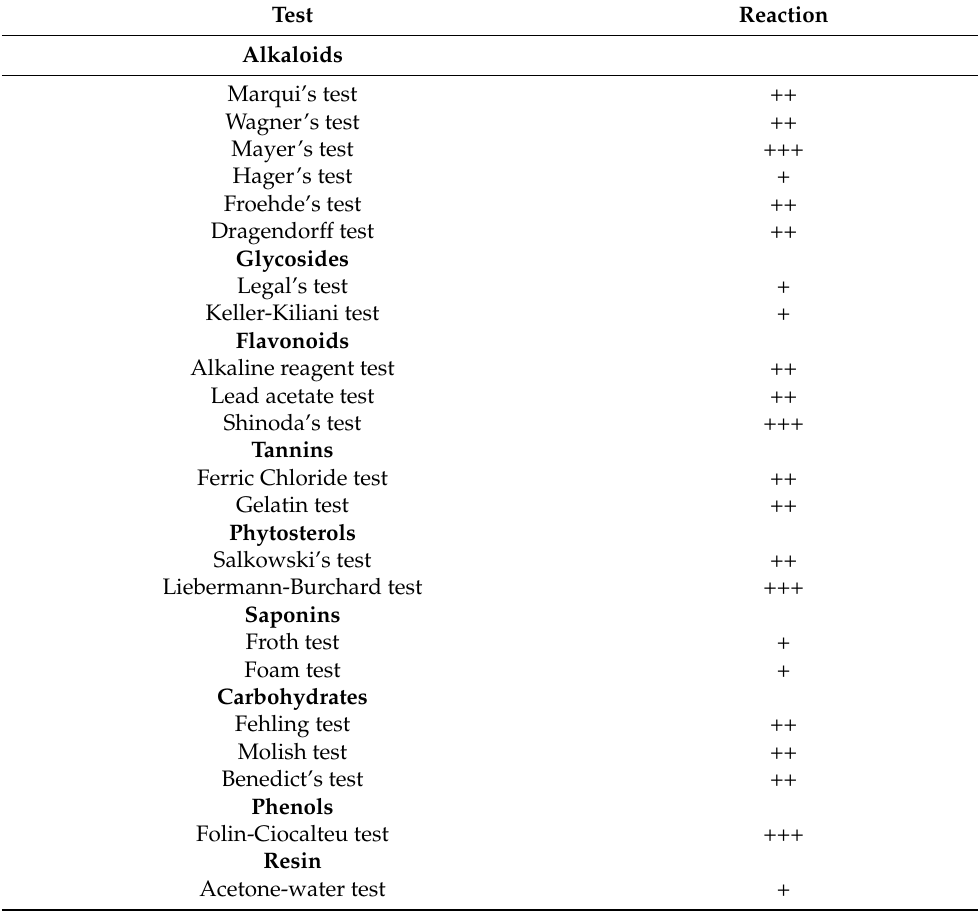
Table 2. Phytochemical constituents in the ethanol extract of A. nilagirica